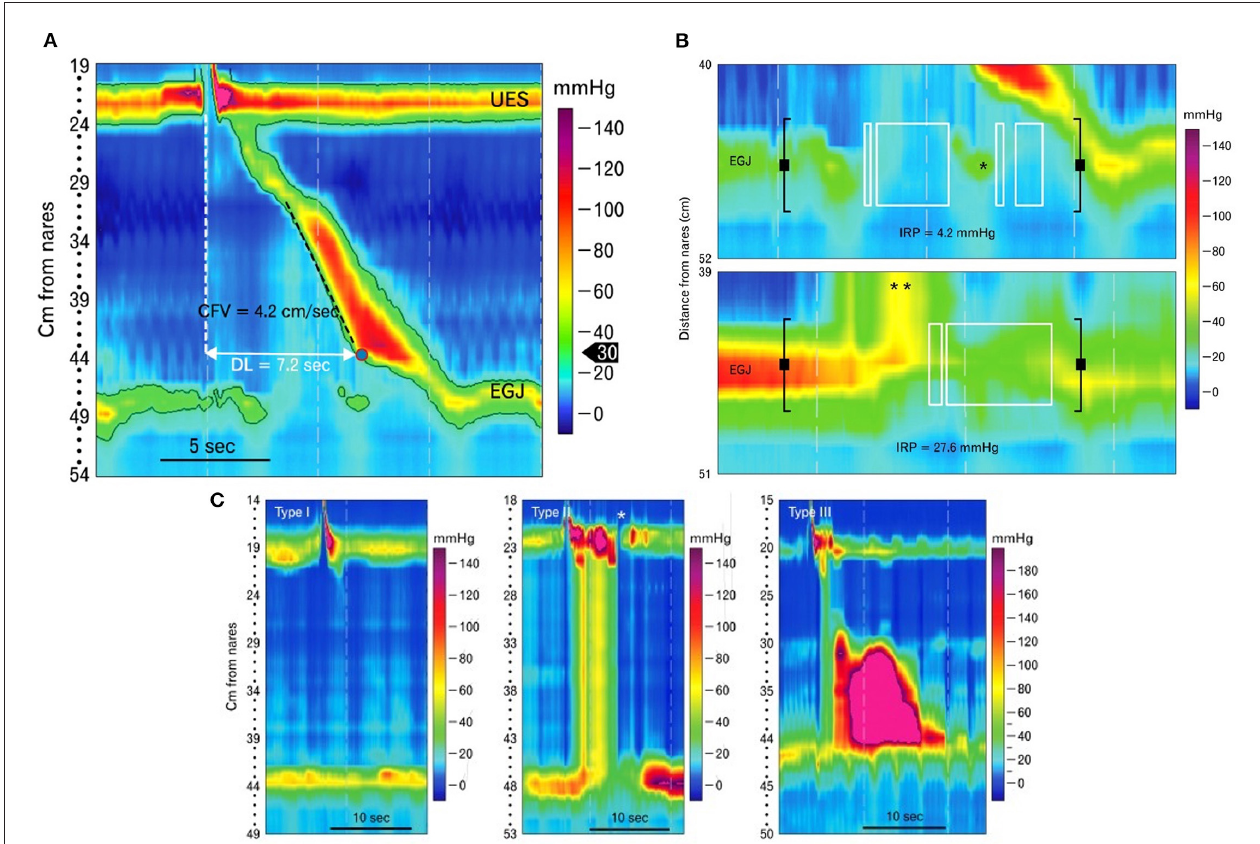
FIGURE 9 | Esophageal pressure topography plots generated using high-resolution manometry in human patients. (A) High-resolution manometry catheters span and simultaneously measure pressures from pharynx to stomach and measure pressure throughout the esophagus. The results are graphically depicted in color contoured esophageal pressure topography plots as seen here. Metrics such as contraction front velocity (CFV) and distal latency (DL) can then be measured and calculated to evaluate esophageal peristalsis. CFV is a measure of peristaltic velocity in the smooth muscle portion of the esophagus. Distal latency is the time from upper esophageal sphincter (UES) opening to the contractile deceleration point (CDP), when peristalsis terminates at the esophagogastric junction (EGJ). (B) The top image shows the pressure topography of the esophagogastric junction (EGJ) following a liquid swallow in a normal human patient. Integrated relaxation pressure (IRP) is measured during a time window (bounded by black brackets) that occurs after upper esophageal sphincter (UES) opening. An eSleeve tool determines the highest pressure at each point in time within this window. An algorithm is then used to average the lowest of those pressures over four continuous or discontinuous seconds (marked by the white boxes). This average is the IRP. The example below is the EGJ pressure topography of a patient with achalasia. Due to failure of lower esophageal sphincter (LES) relaxation, excessive pressurization of the swallowed bolus occurs above the LES (**) and IRP is elevated. (C) Esophageal pressure topography plots showing the three different types of achalasia from left to right: Type I, II, and III. Achalasia is defined by a failure of normal peristalsis and lower esophageal sphincter opening and can be further classified into 3 types. Type I is characterized by absence of peristaltic activity in the esophagus without esophageal pressurization, type II by panesophageal pressurization and type III by premature esophageal contractions. The asterisk in the middle panel points to a brief opening of the UES that is not associated with a pharyngeal contraction or swallow and is therefore an example of the UES opening to vent. The images in this figure were published in Journal